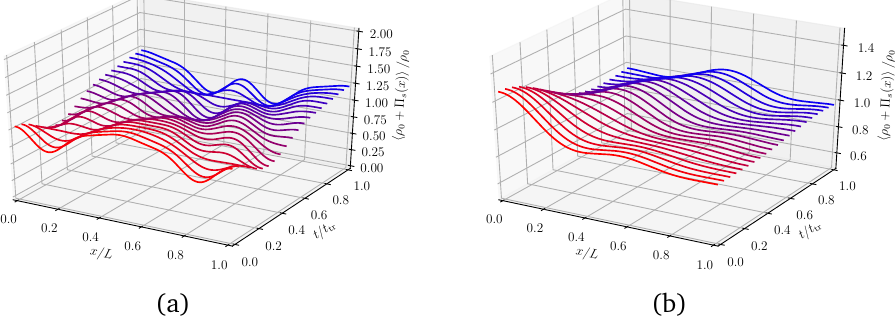
Figure 6: Examples of the time evolution of the density profile for σ = 0. The initial profile in (a) is symmetric around the origin, while the one in (b) is